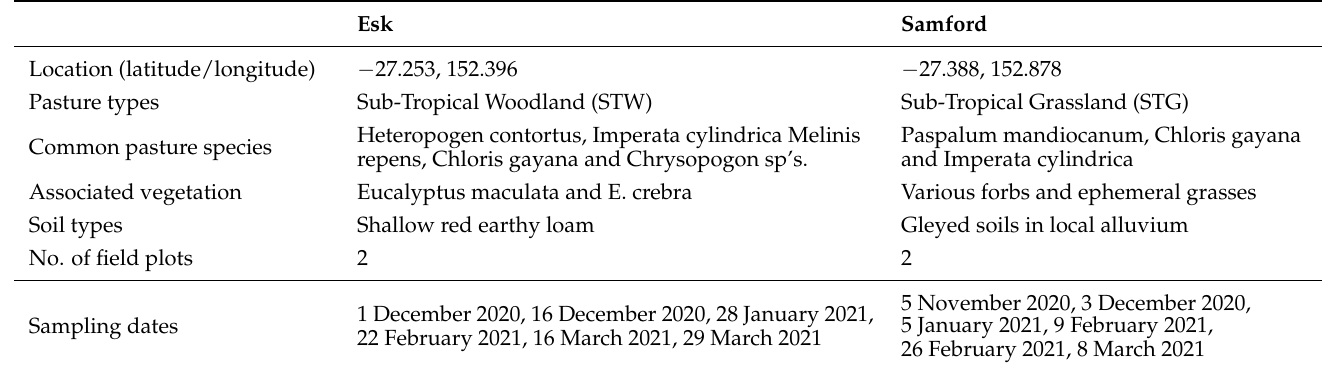
Table 1. Field site characteristics.